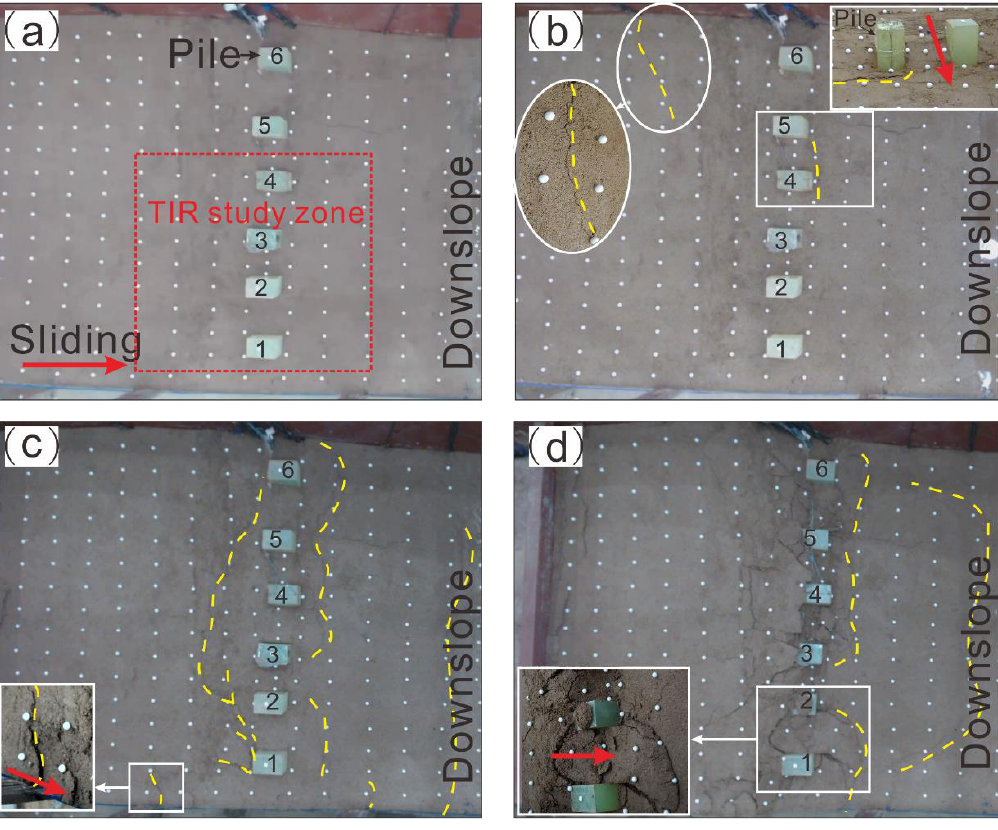
Figure 2. Deformation characteristics of the model surface at ( a ) 0.0h, ( b ) 6.5 h, ( c ) 10.5 h, ( d ) 12 h.